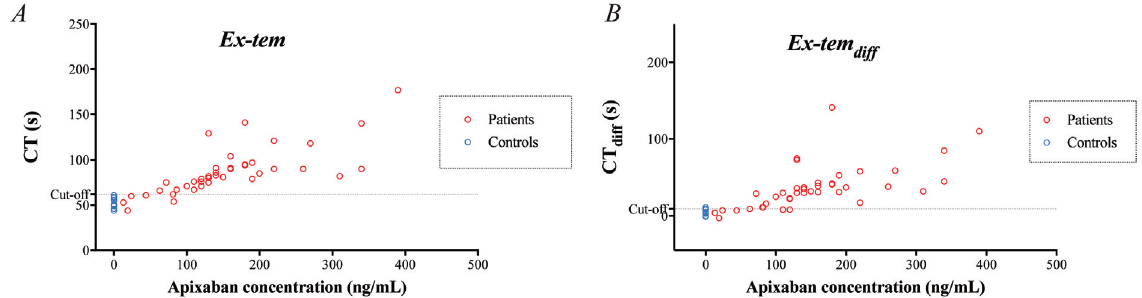
Fig. 4 Rotational thromboelastometry (ROTEM) analyses using the Ex-tem trigger – variables clotting time (CT) ( A ) and CT diff ( B ; the difference in CTwithout vs. with DOAC-Stop [DS]) – performed on blood samples from 40 patients on apixaban treatment. Variablespresented in relation to apixaban concentration measured by liquid chromatography with tandem mass spectrometry (LC-MS/MS). Cutoff line represents optimal receiver operating characteristics (ROCs) for discriminating between samples with apixaban concentration above or below 20ng/mL.